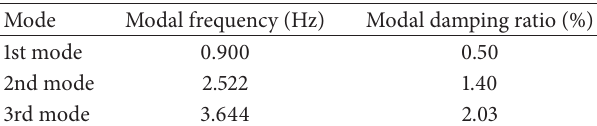
Table 5: Identified modal frequencies and damping ratios for Case 1 .